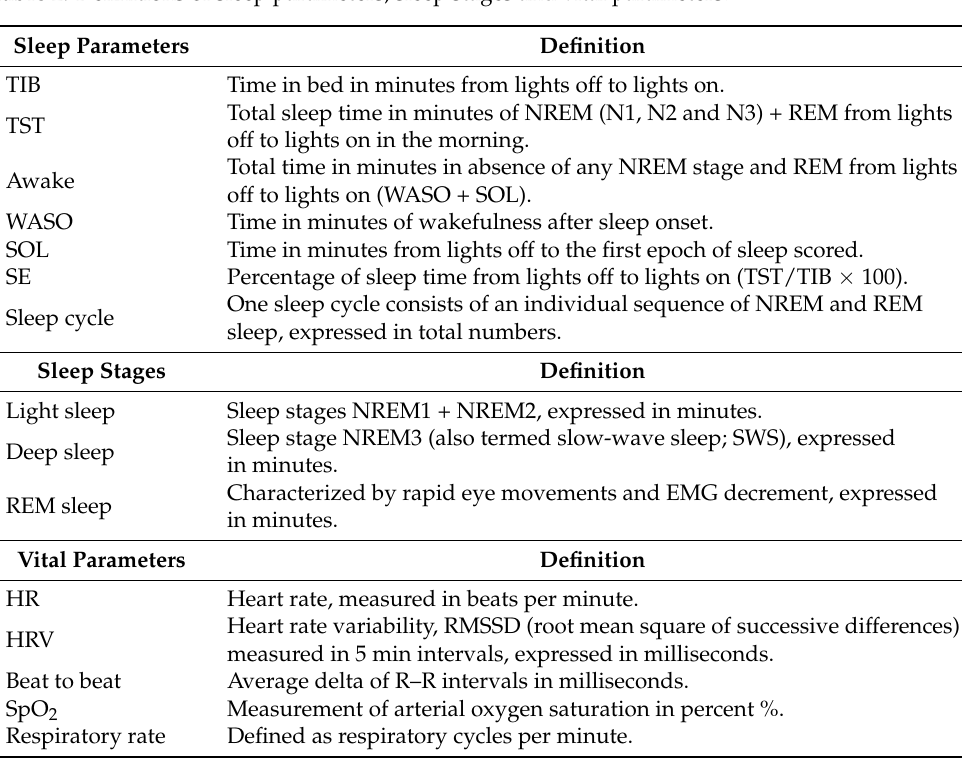
Table 2. Definitions of sleep parameters, sleep stages and vital